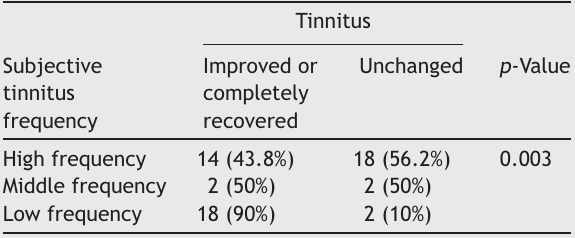
Relationship between tinnitus frequency and post- operative tinnitus status.